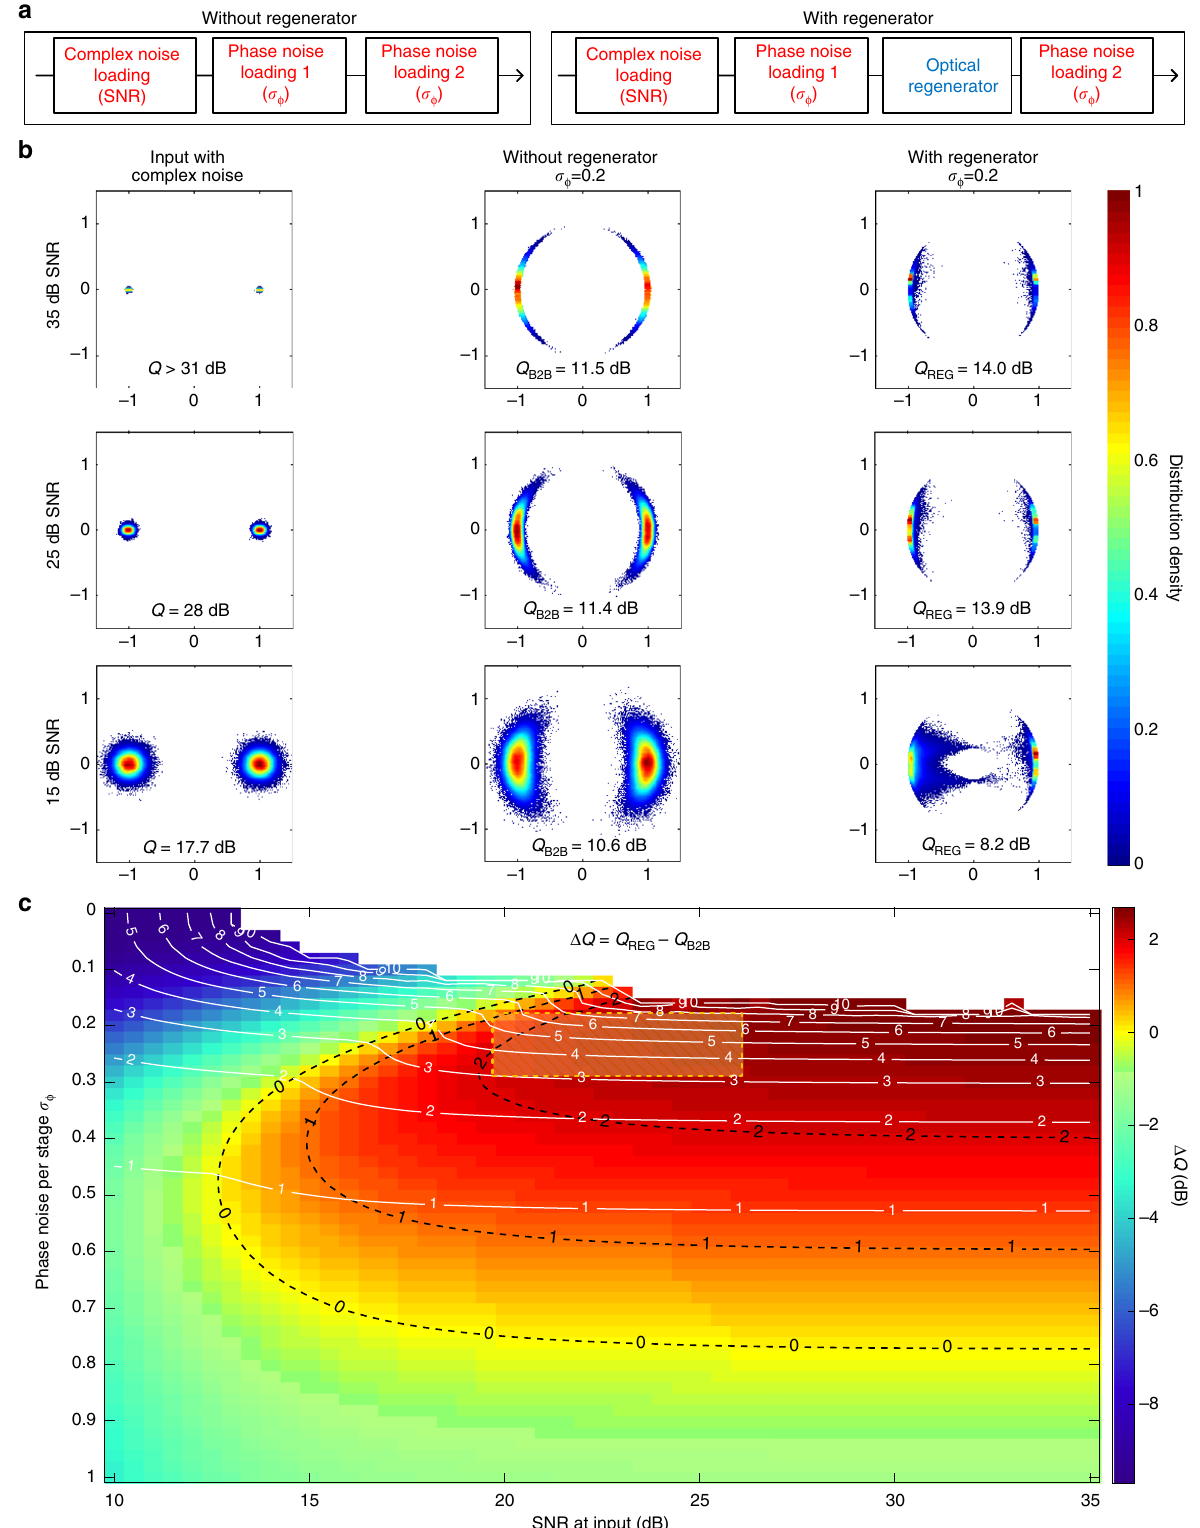
Fig. 8 Numerical analysis of the regenerator with complex noise and with phase noise only. a Simulation block diagrams with and without regenerator. b Simulated constellation diagrams with 35, 25 and 15 dB complex noise at the input, without regenerator, and with regenerator. c Monte Carlo simulation results, regeneration performance Δ Q as shown in the colour map by sweeping both the SNR and the phase noise per stage σ ϕ = σ 1 ϕ = σ 2 ϕ . The black dashed lines indicate contours of Δ Q , and the white lines indicate best achievable BER (with or without regenerator: when Δ Q > 0, the best achievable BER is obtained with regenerator). The top area with BER < 10 − 10 is shown in white, where reliable results are more computationally challenging to achieve, and the approximate experimental conditions are indicated by yellow dashed